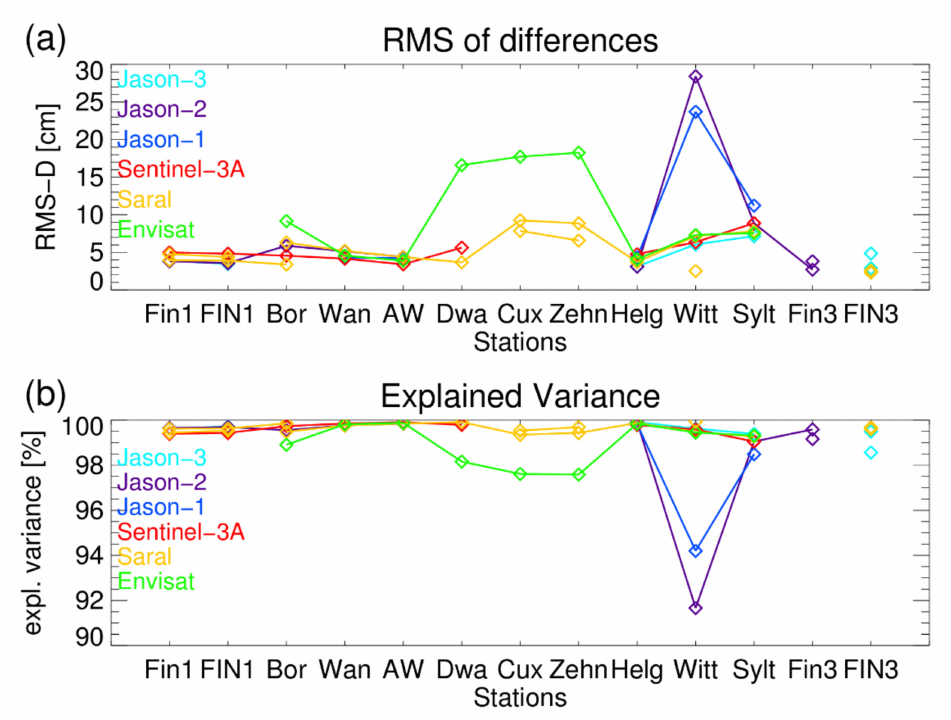
Figure 7. ( a ) RMS-D (cm) and ( b ) explained variance (%) counterclockwise along the coast for FINO1 (Fin1, FIN1), Borkum Südstrand (Bor), Wangerooge Nord (Wan), LT Alte Weser (AW), Dwarsgat (Dwa), Cuxhaven (Cux), Zehnerloch (Zehn), Helgoland Binnenhafen (Helg), Wittdün (Witt), Sylt (Sylt) and FINO3 (Fin3, FIN3). Missions are color